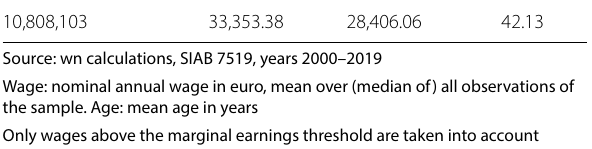
Table 9 Selected 2014 and 2018 wage percentiles and wage percentile ratios for VSE, SOEP, and SIAB